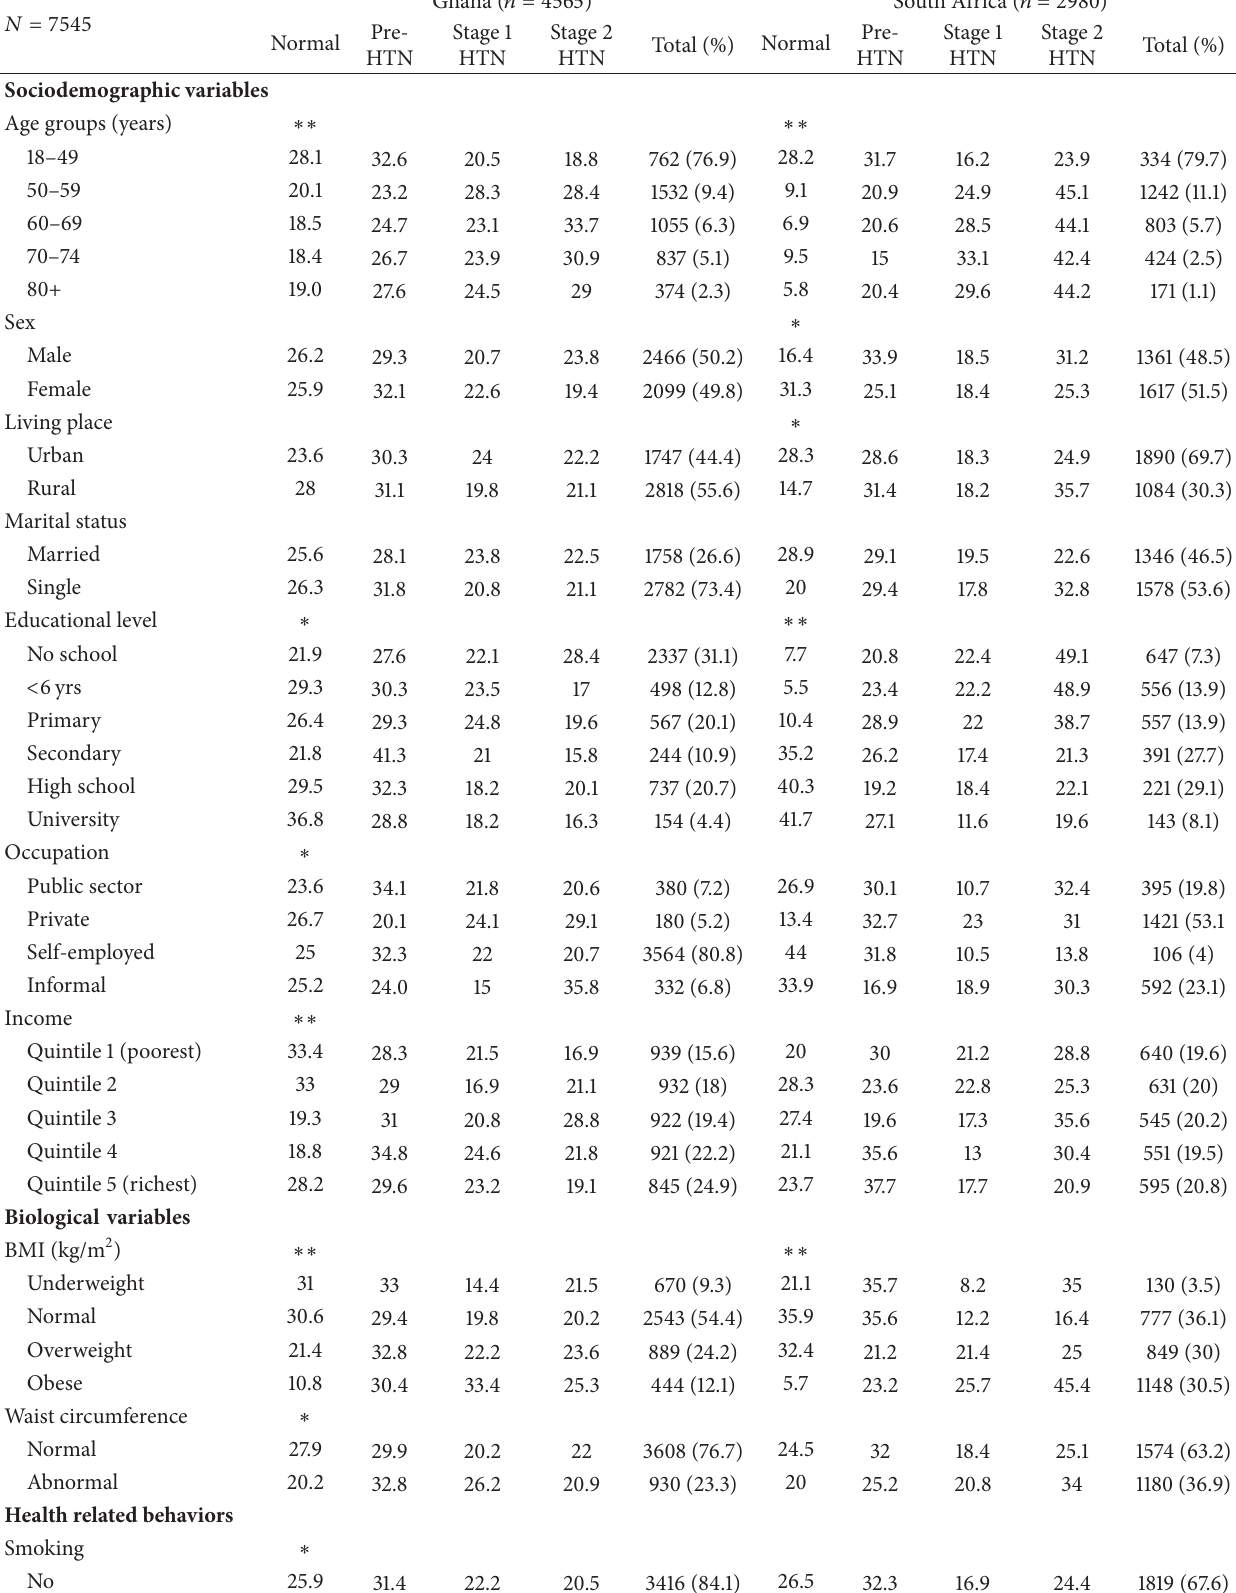
Table 1: Sociodemographic, health behavior, and biological characteristics (%) of study subjects, by country and hypertension stages. 𝑁 =